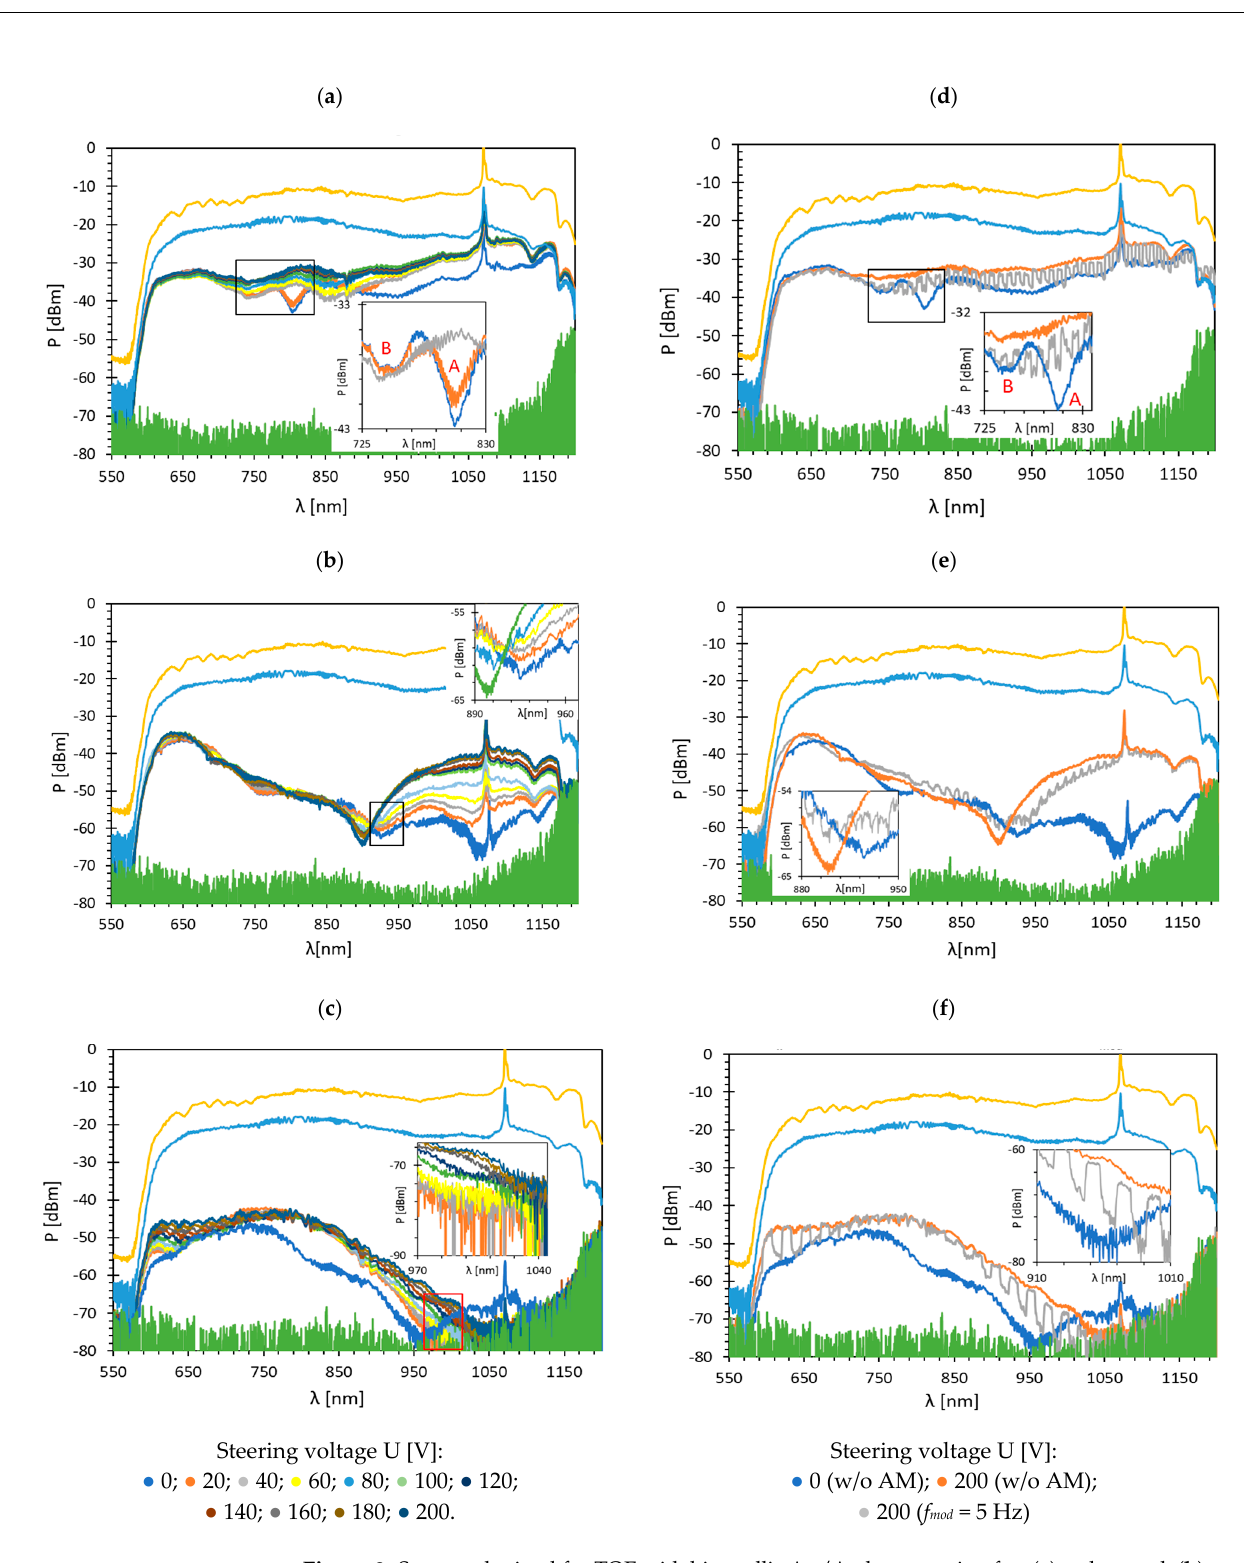
Figure 3. Spectra obtained for TOF with bimetallic Au/Ag layer coating for: ( a ) orthogonal; ( b ) parallel; ( c ) twisted cell under voltage U: 0–200 V w/o AM, and dynamic response of: ( d ) orthogonal; ( e ) parallel; ( f ) twist cell with f mod = 5 Hz with 100% AM.